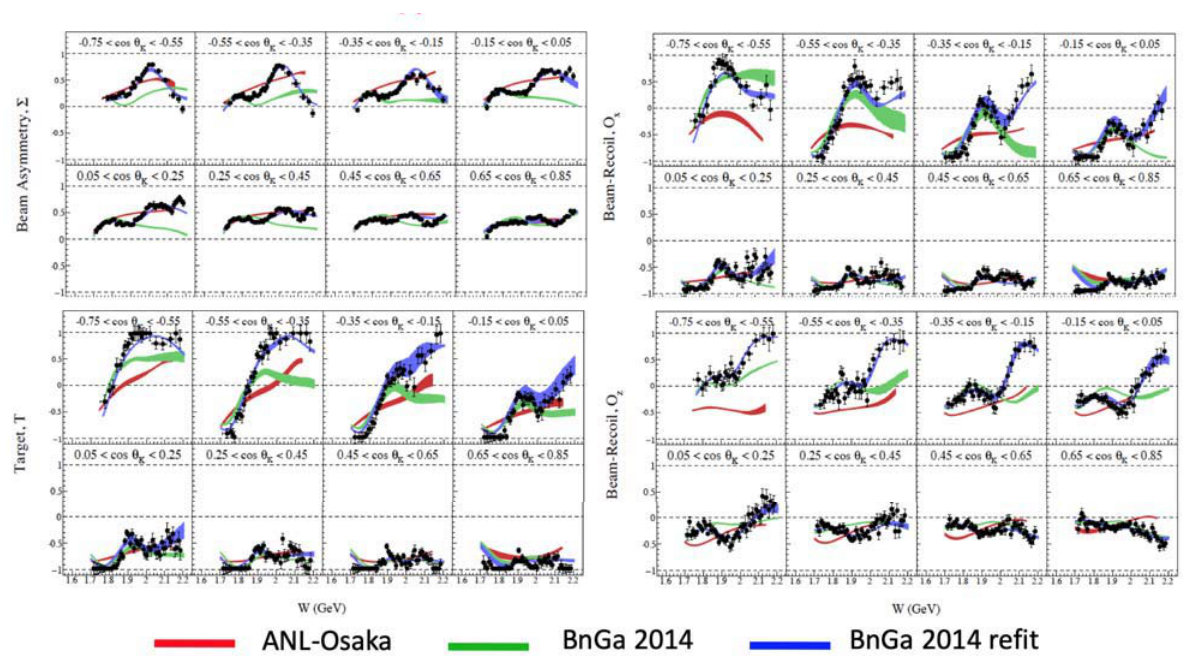
Fig. 8 Beam and Target polarization asymmetries (left panel), and beam-recoil polarization asymmetries (right panel) mea- sured by the CLAS collaboration in the γp → K + Λ channel. The projections from earlier analyses. shown in the red and green bands, show large discrepancies with the data in the higher W range. A refit by the BnGa group (blue band) shows that the discrepancies do not require new excited states but could be accommodated by just adjusting some parameters.